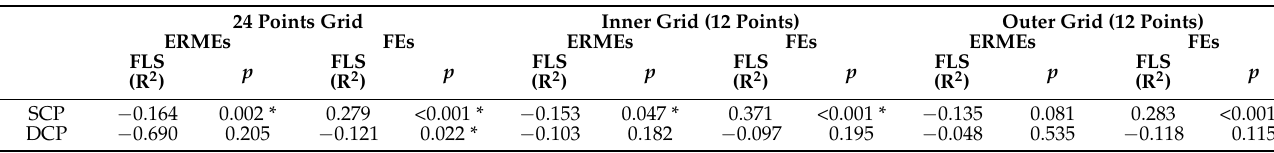
Table 2. Correlations between morphological (SCP, DCP) and functional (FLS) parameters in global, inner and outer grids.